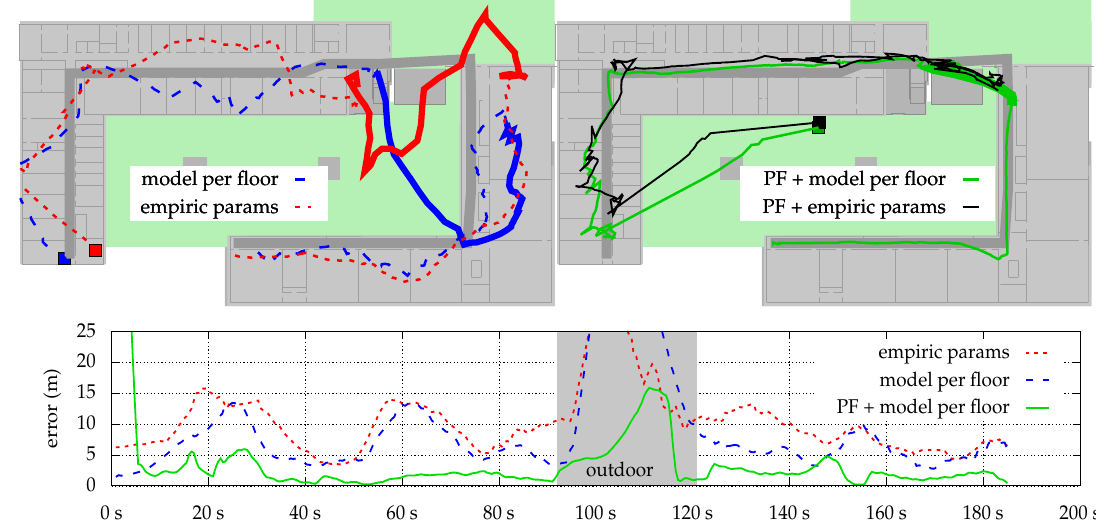
Figure 11. Detailed analysis of the Wi-Fi error for empiric params (unoptimized) and model per floor using Path 1 (see Figure 7). While optimization reduces the error indoors, the error outdoors is increased (bold line). A particle filter (PF, Equation (1)) on top of the optimized model takes 5s to initialize the starting-position (rectangles), fixes the outdoor-issue and improves indoor situations. A filter on top of empiric params got stuck right before entering the second building. Both, the filtered and unfiltered version of empiric params are dragged into the second floor in the middle of the walk. As the particle filter starts uniformly distributed along the whole area, the initial estimations determine the pedestrian’s position to be in the center of the area (average position among all particles). The black and green walks thus start in empty space above the ground. After a few filter updates (see first seconds of the error plot) the estimation represents the pedestrian’s actual position within the